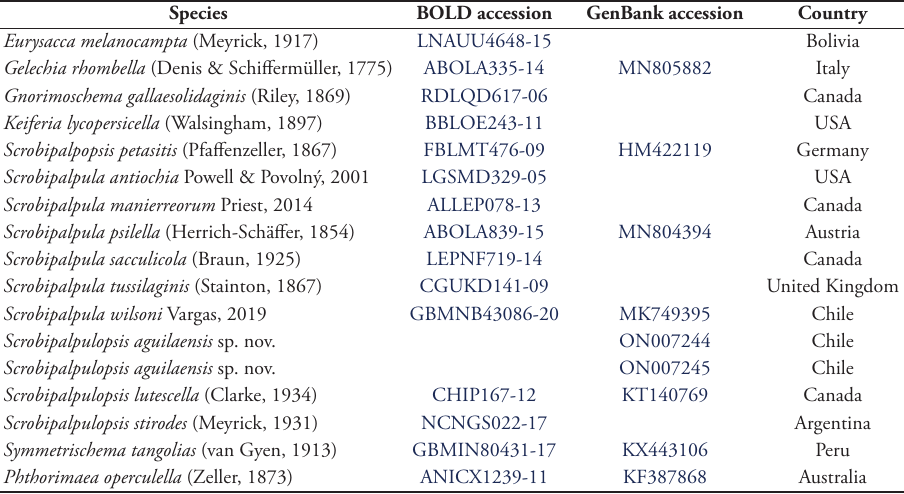
Table 1. DNA barcode sequences (658 bp length) used in the molecular analysis. Species BOLD accession GenBank accession